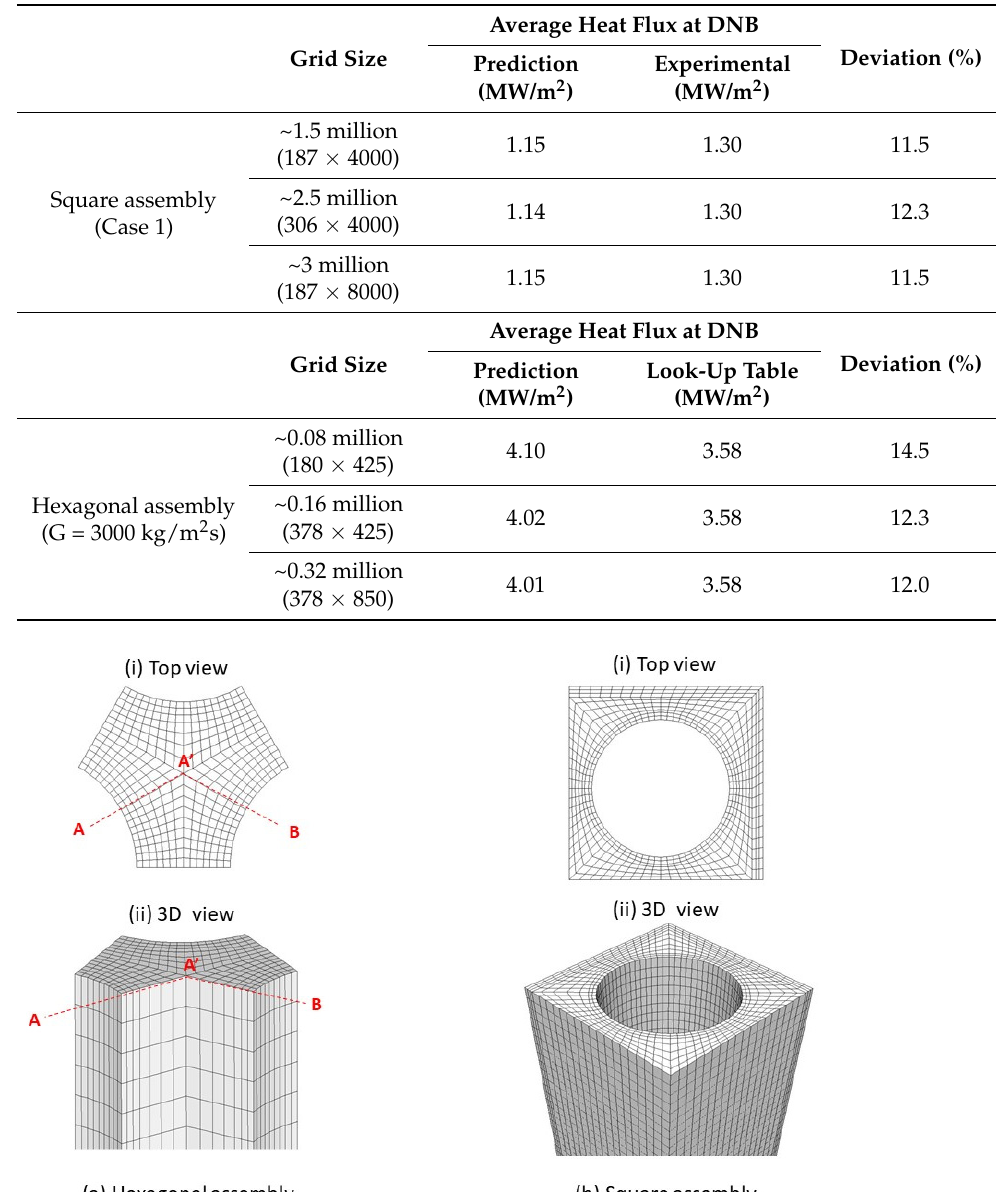
Table 5. Grid sensitivity study for hexagonal and square rod bundles.